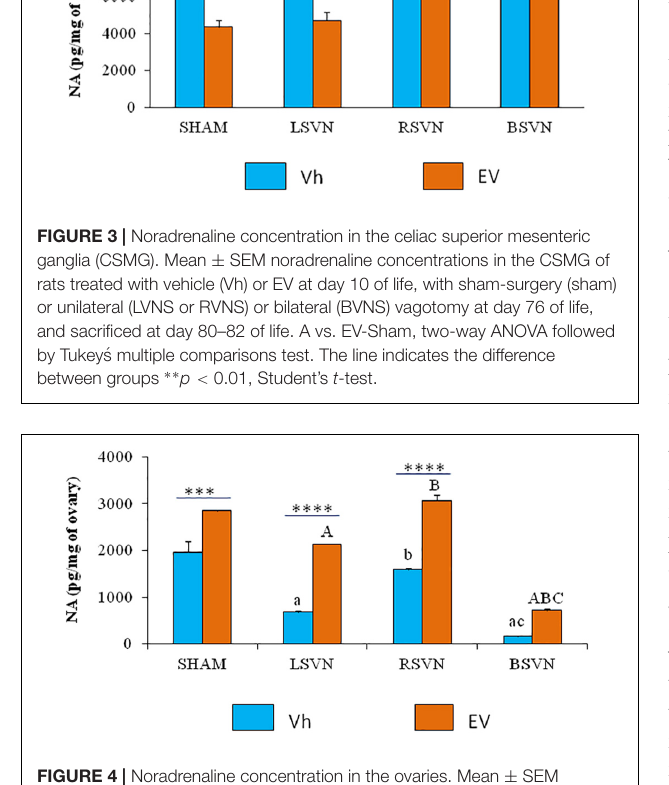
FIGURE 4 | Noradrenaline concentration in the ovaries. Mean ± SEM noradrenaline concentrations in the ovaries of rats treated with vehicle (Vh) or EV at day 10 of life, with sham surgery (sham) or unilateral (LVNS or RVNS) or bilateral (BVNS) vagotomy at day 76 of life, and sacrificed at day 80–82 of life. a vs. Vh-sham; b vs. Vh-LVNS; c vs. Vh-RVNS; A vs. EV-sham; B vs. EV-LVNS; C vs. EV-RVNS, two-way ANOVA followed by Tukey´s multiple comparisons test. The line indicates the difference between groups ∗∗∗ p < 0.001, ∗∗∗∗ p < 0.0001, Student’s t